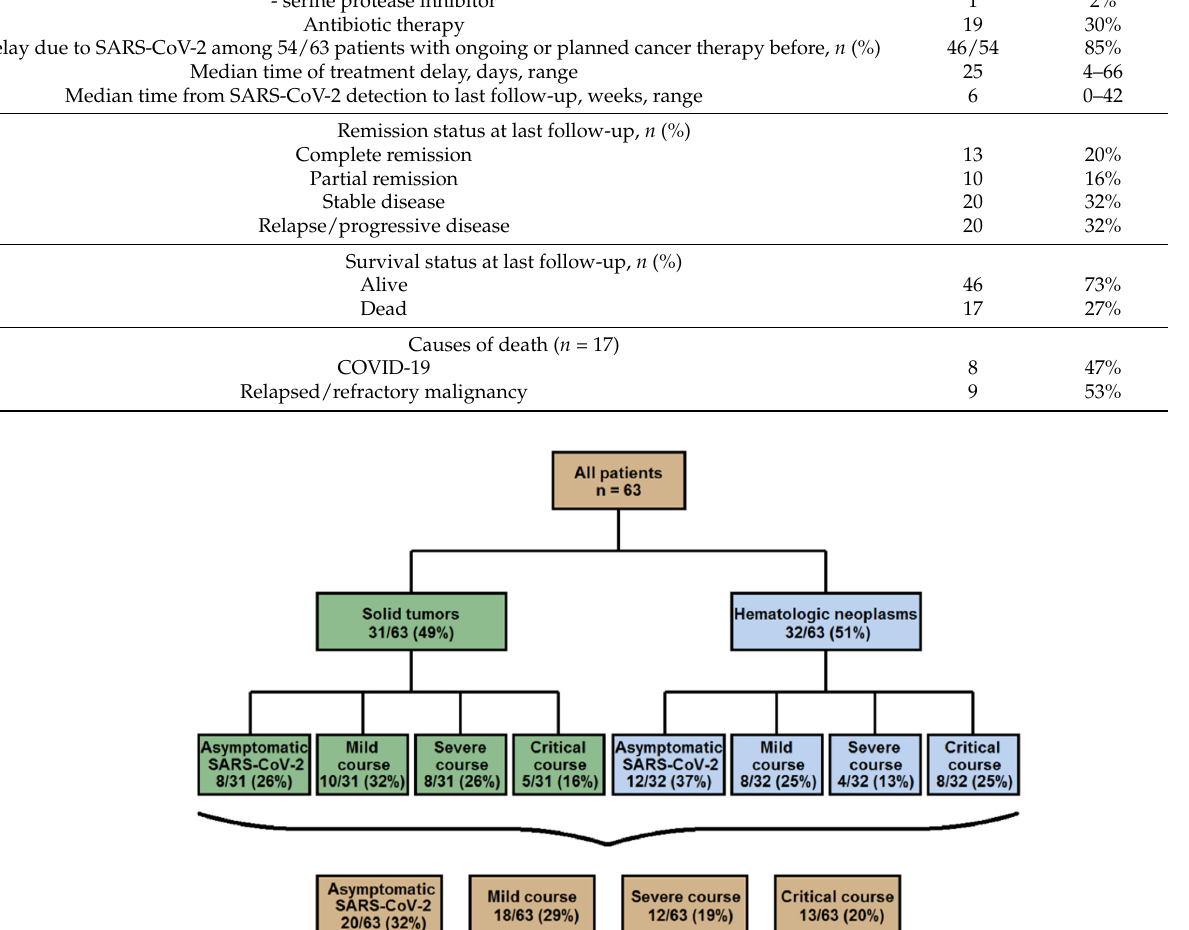
Figure 2. Distribution of SARS-CoV-2 infection severity.